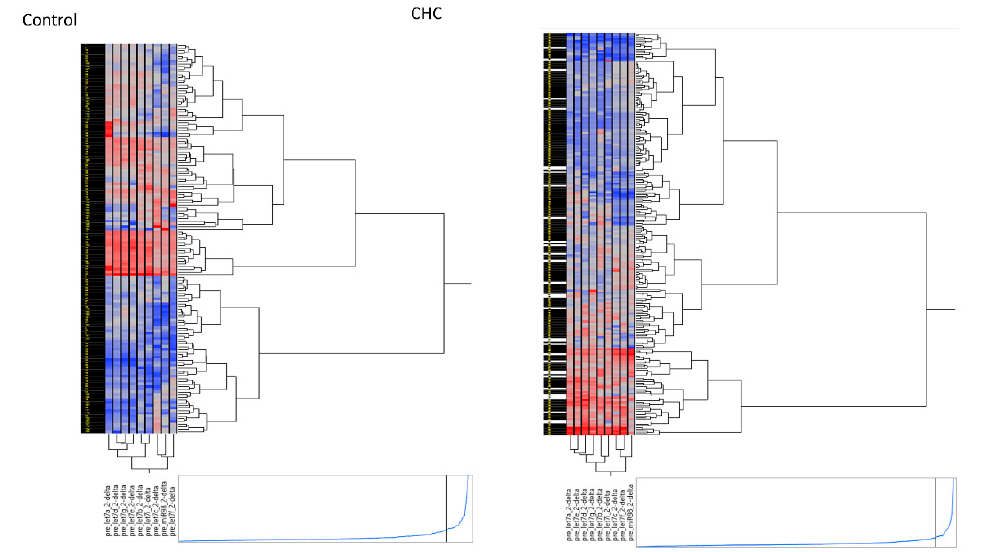
Figure 1. Hierarchical clustering plot (heatmap) of circulating let-7 family in the control group without hepatitis C virus (HCV) infection ( n = 147) and HCV-infected patients ( n = 236).